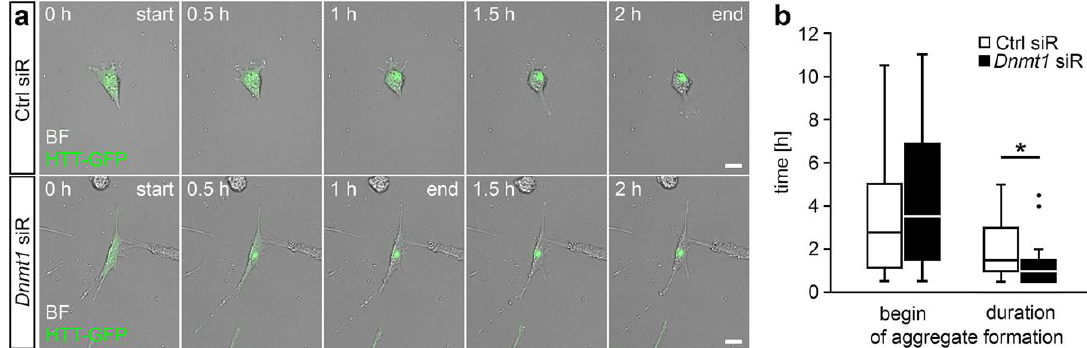
Figure 4. Dnmt1 knockdown led to a faster aggregate formation of mutant HTT in CB cells. ( a ) Representative microphotographs of CB cells expressing GFP-labeled mutant HTT (green) and transfected with either Ctrl or Dnmt1 siRNA, showing the temporal differences in the aggregate formation of mutant HTT. ( b ) Quantification of the start and the duration of aggregate formation depicted in ( a ) for cells transfected with Ctrl siRNA ( n = 27 cells) or Dnmt1 siRNA ( n = 33 cells; two-sided Student’s t -test, * p < 0.05). BF = bright field, Ctrl = control, HTT = Huntingtin, siR = siRNA. Scale bars: 20 µm in ( a ).